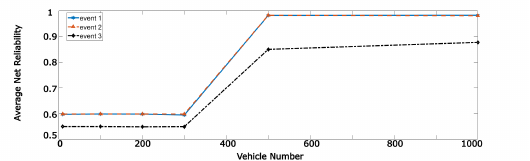
Figure 10. Net reliability with respect to the number of vehicles.